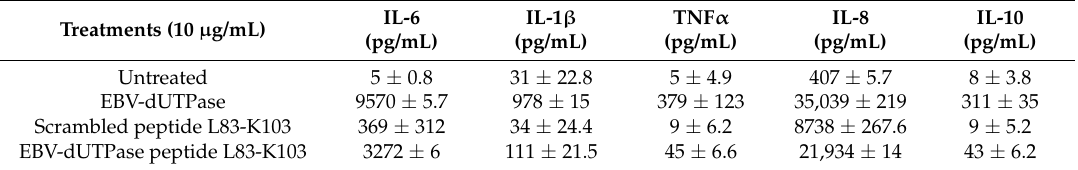
EBV-dUTPase peptide L83-K103 3272 ±